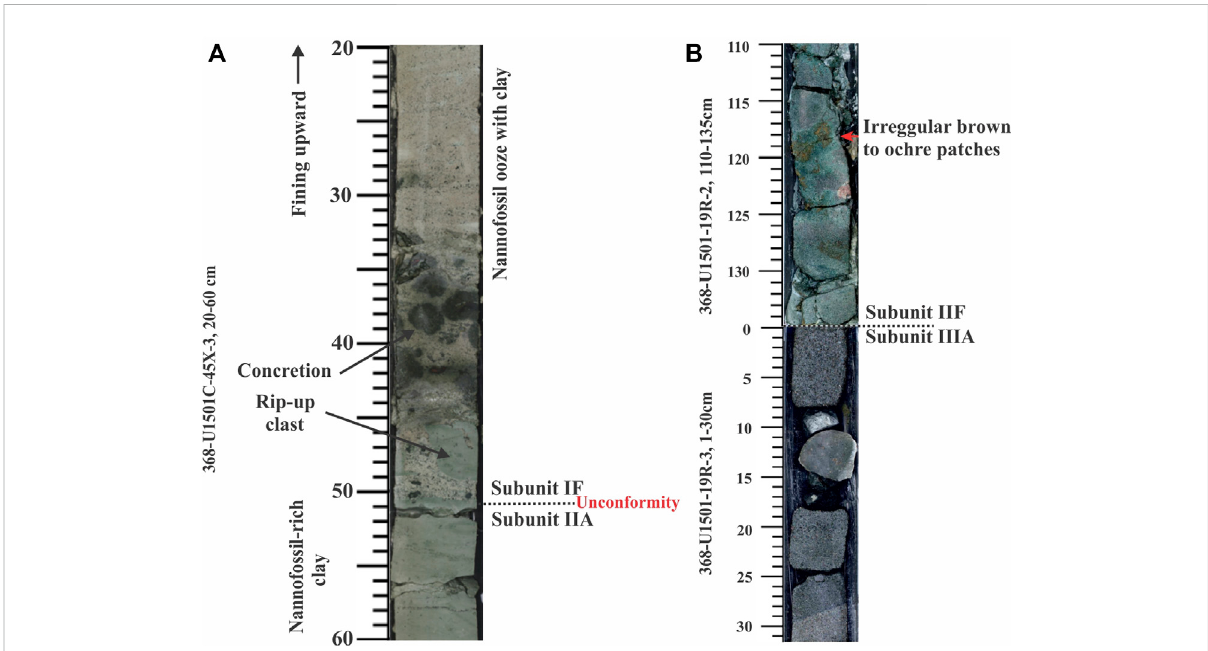
FIGURE 3 (A) Core photo showing the boundary between Units I and II (368-U1501C-45X-3, 20 – 60 cm) which represent unconformity. Nannofossil ooze with clay and dominates Subunit IF with centimeter-sized concretions at the lower boundary and rip-up clasts. Subunit IIA is dominated by nannofossil-rich clay; (B) Images of core section from IODP site U1501 showing the change of lithology from Subunit IIF to Subunit IIIA and the boundary represent non-depositional hiatus. The lower red arrow of Subunit IIF shows irregular brown to ochre and purple patches inferred to be related to diagenetic alteration (Sun et al.,